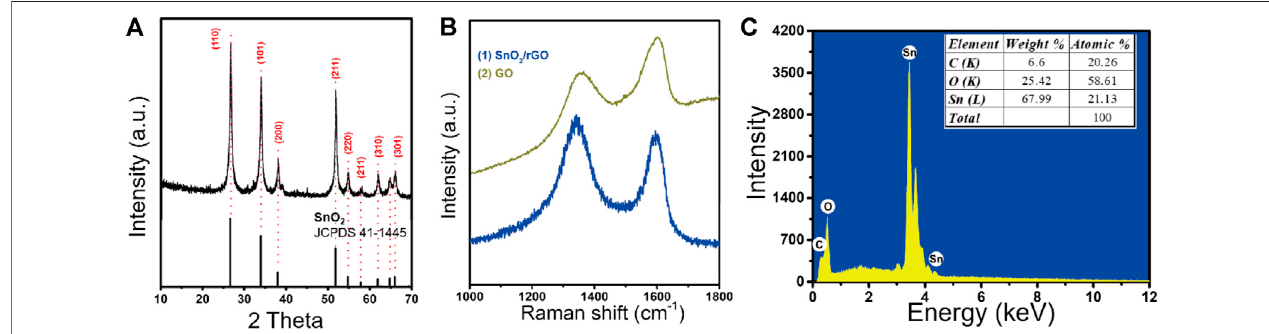
FIGURE 1 | (A) The XRD patterns of SnO 2 /rGO composites; (B) the Raman spectra of SnO 2 /rGO composites and GO; (C) the EDS analysis of SnO 2 /rGO